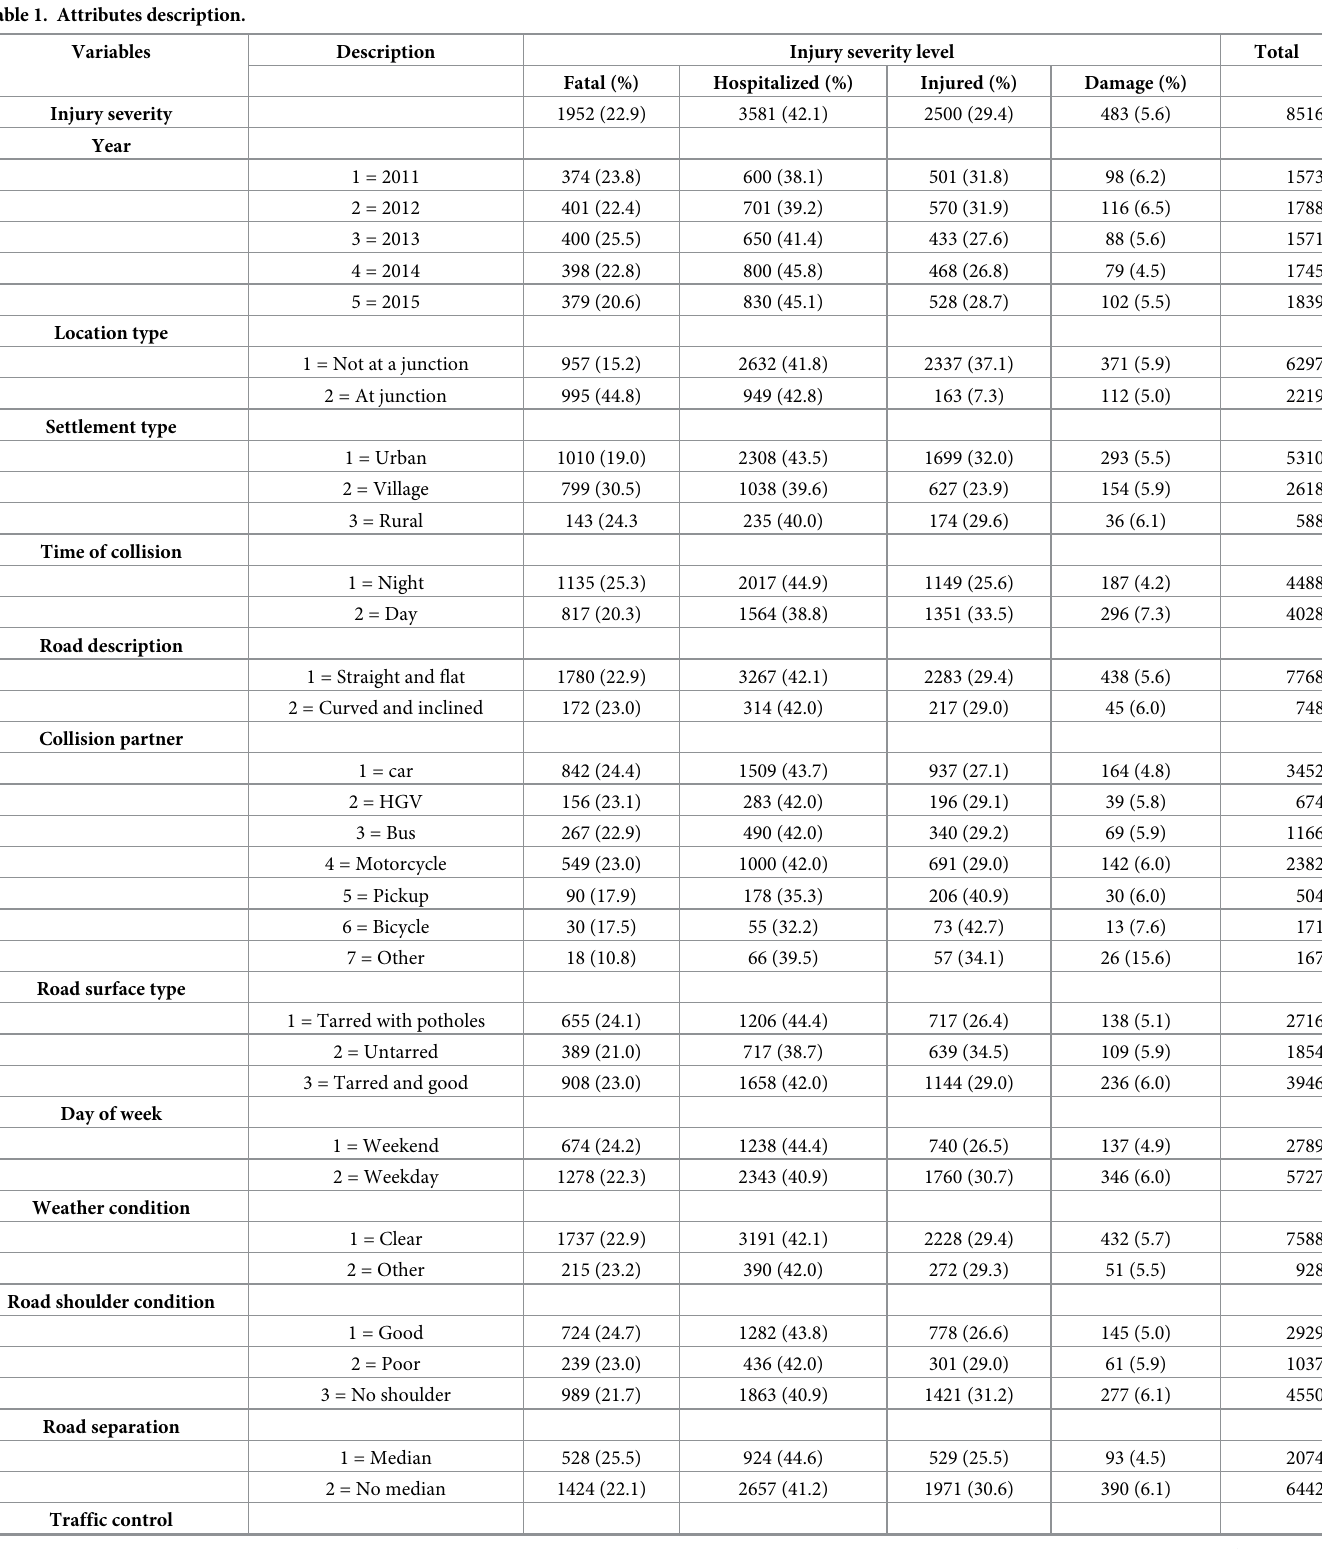
Table 1. Attributes